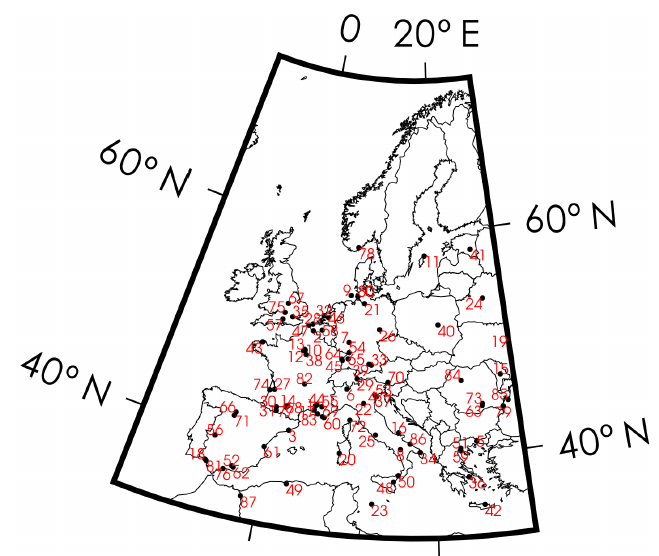
Figure 1. Location of AERONET stations used for the validation of modelling results. The number in the Figure corresponds to the stations detailed in Table 1, where stations are listed by code longitude, latitude, name, and corresponding number in this figure. Table 1. Location, number, and name of all AERONET stations included in this contribution for AOD675 evaluation.